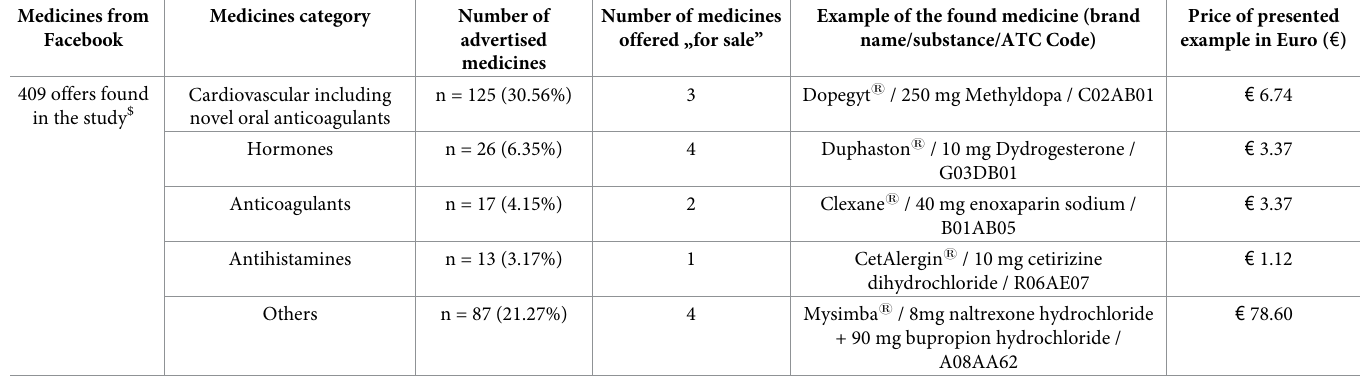
Table 1. The examples of medicines found on Facebook #